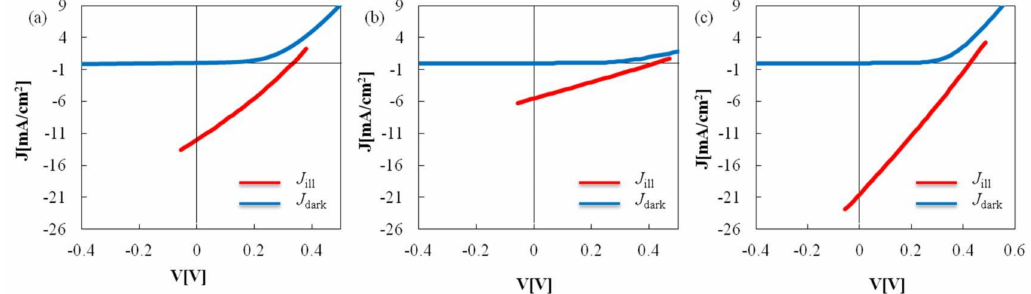
Figure 7. J-V measurement results of CIS films which constituted by using Cu-In nanoparticles synthesized at ( a ) PVP(K16–18) and Cu/In = 0.91; ( b ) PVP(K25) and Cu/In = 0.91; and ( c ) PVP(K25) and Cu/In = 0.81, under AM 1.5G illumination and in the